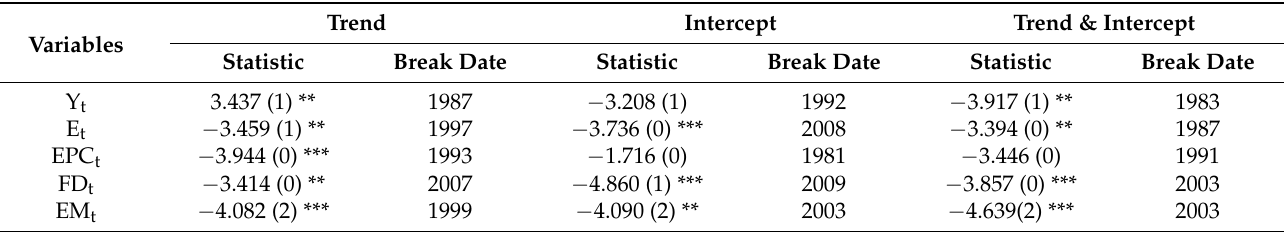
Table 3. Zivot–Andrews structural break unit root